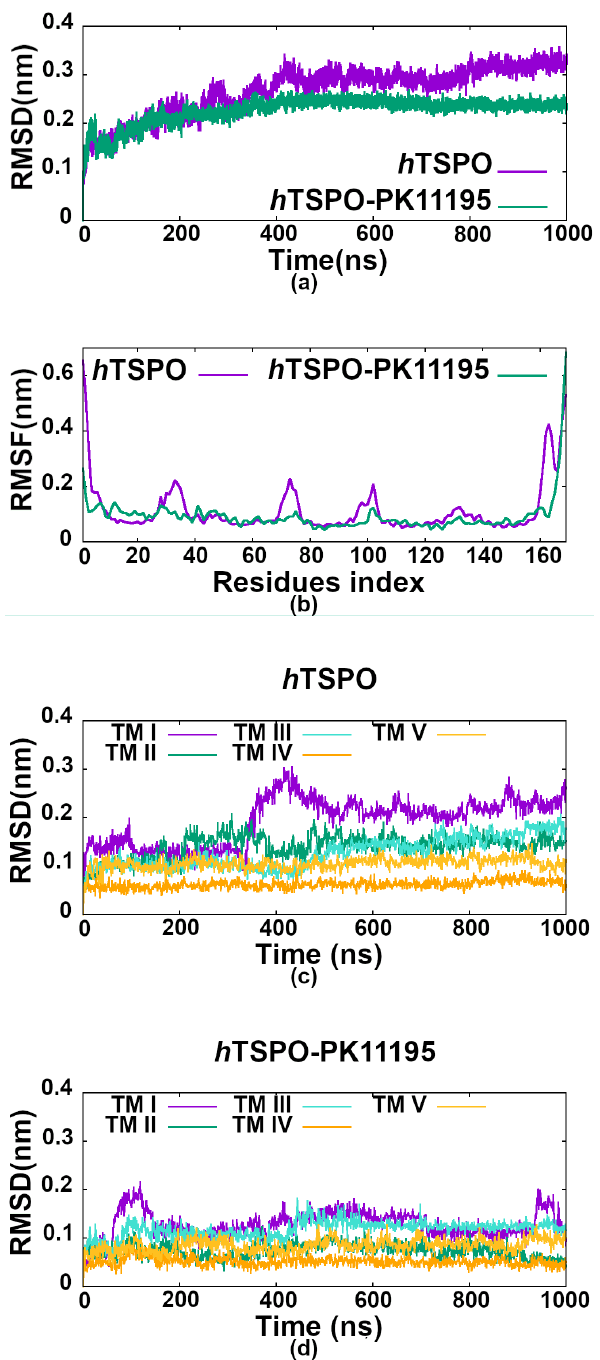
Figure 4. ( a ) Evolution of the root mean squared deviation (RMSD) values of the apo (violet graph) and holo (green graph) h TSPOs during the 1 µ s long MD simulation. RMSD values were calculated for the backbone atoms of residues W5 to N158, excluding the N– and C–termini and H atoms. ( b ) Root mean squared fluctuations (RMSF) of the C α atoms in the apo (violet graph) and holo (green graph) h TSPOs. RMSF values were calculated for equilibrated proteins (in the MD simulation range of 400 ns–1 µ s). ( c , d ) RMSD values for each of the five transmembrane helices (TM I–TM V) in the apo ( h TSPO) and holo ( h TSPO–PK11195) proteins,